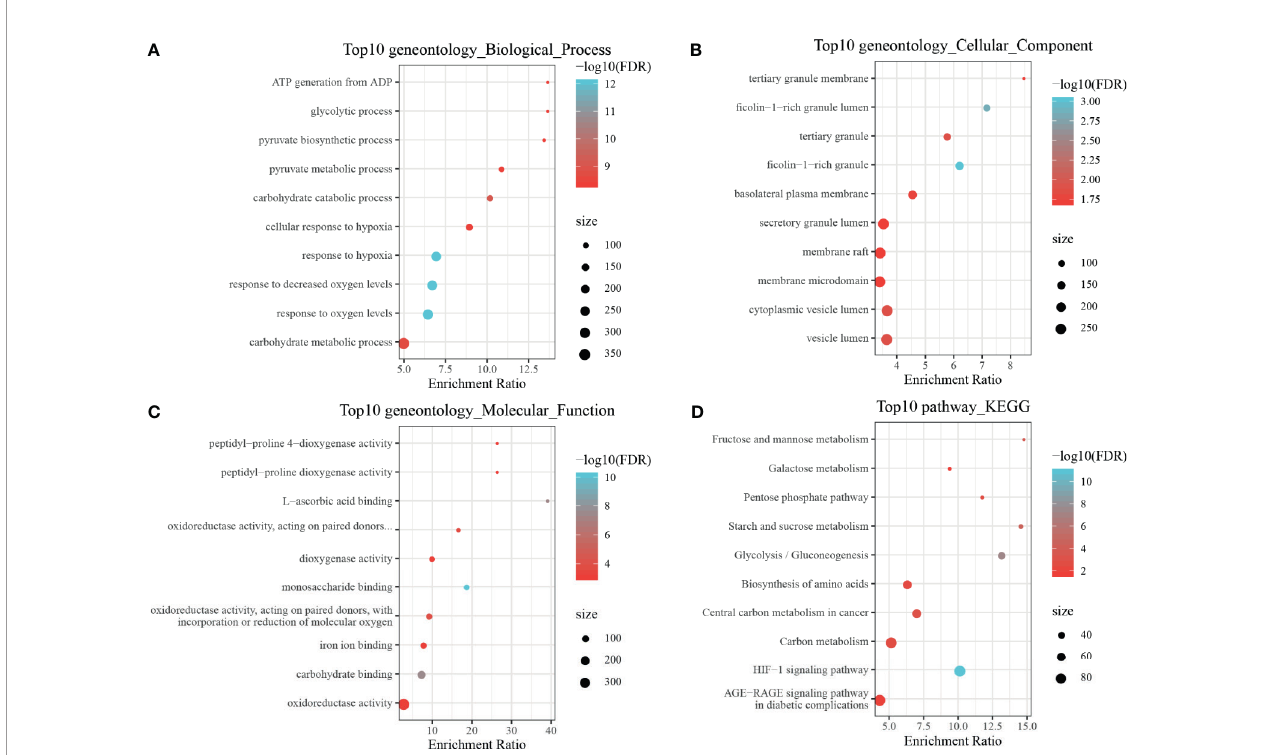
FIGURE 3 | Enrichment analyses of TNBC-speci fi c dHRGs. Biological processes (A) , cellular components (B) , molecular functions (C) , and Kyoto Encyclopedia of Genes and Genomes (KEGG) pathways (D) enriched in the TNBC-speci fi c